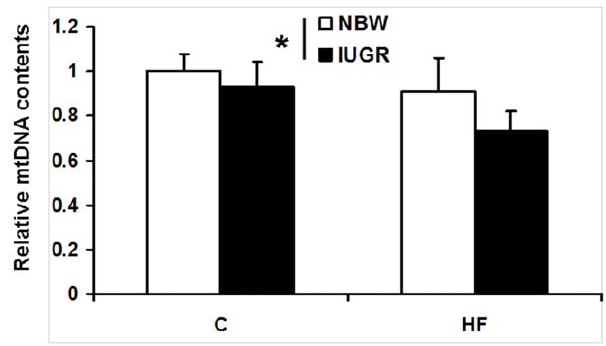
Figure 7. Influence of IUGR and diet on relative mtDNA contents in skeletal muscle of pigs. C: Control diet; HF: High-fat diet; NBW: Normal birth weight; IUGR: Intrauterine growth retardation. Data are expressed as group means 6 SEM. * P values next to each label represent the significance in the effect for each source of variation (IUGR or diet) as calculated by ANOVA. 1 P , 0.05 in post hoc test comparing IUGR and NBW offspring receiving the same diet (n=8 by